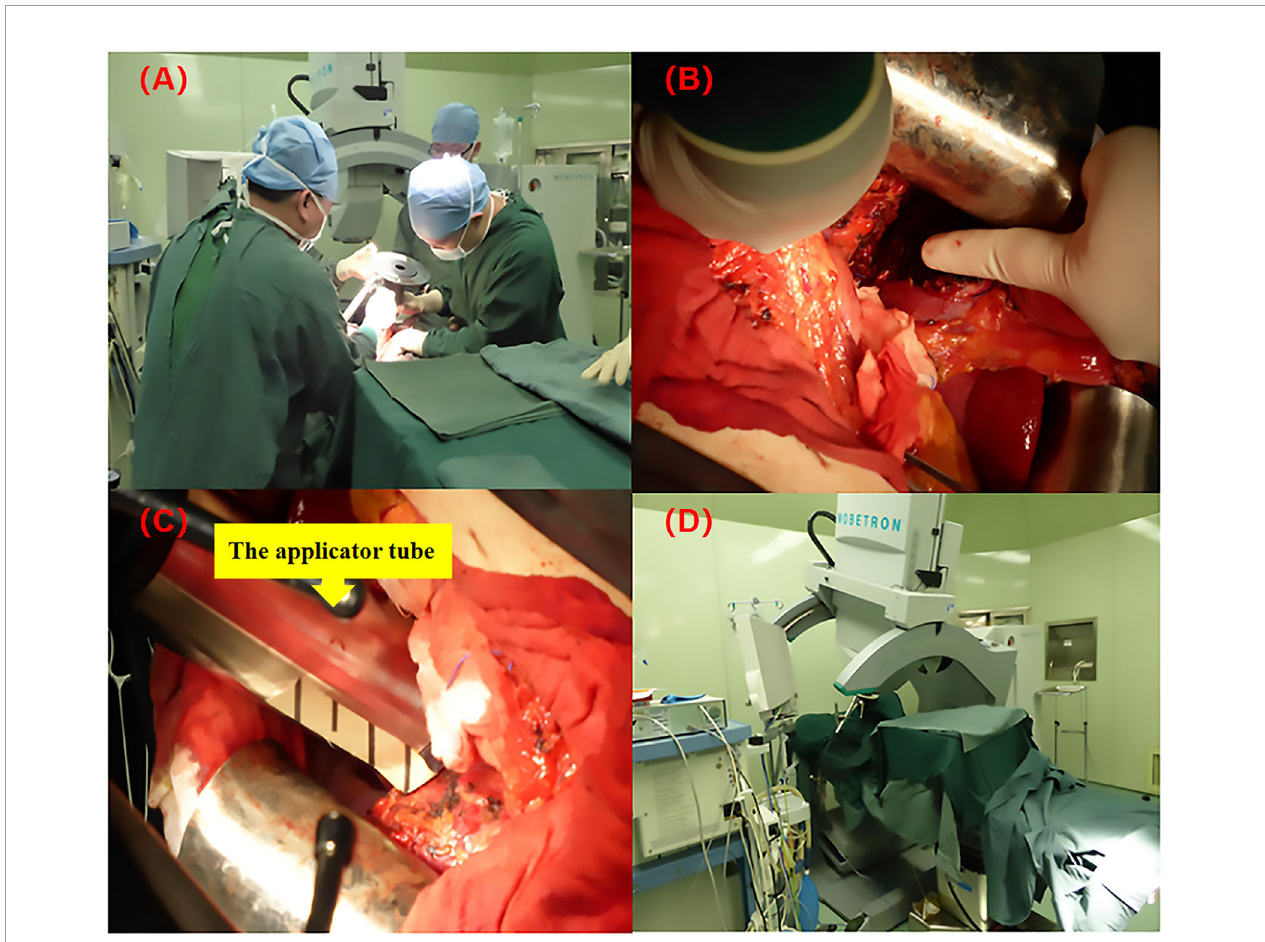
FIGURE 1 | The IOERT process using the Mobetron 2000 mobile electron accelerator. (A) Radiotherapists and surgeons are con fi rming the target volume of IOERT; (B) The resected margin receiving IOERT, only extended to the high risk area near to the major vasculature, duct structures and the deep resected margin (the direction of the fi nger); (C) The applicator tube was placed under visual control (the diameter of applicator tube was ranged from 3 to 10 cm, and was available in 0.5 cm steps with 0°, 15°, and 30° angles); (D) IOERT was administered using a Mobetron 1000 mobile intraoperative radiotherapy accelerator (Intraop Medical Corporation, Sunnyvale,